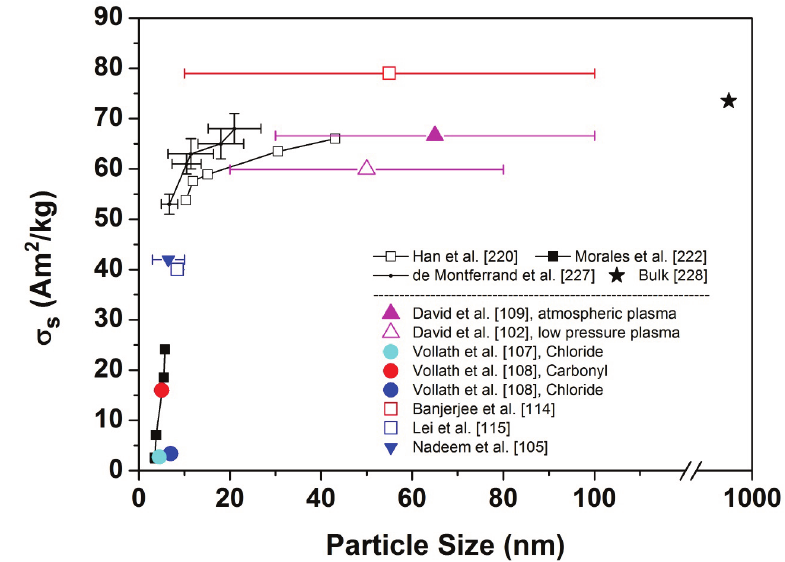
Figure 7. Room temperature saturation magnetization as a function of particle size. Reference data for particle size dependent saturation magnetization (all symbols in black color) are taken from Han et al. [220], Morales et al. [222], and de Montferrand et al. [227], and finally the bulk reference value is taken from [228], page 993. Literature data of the diverse plasma synthesized F O nanoparticles (colored symbols) are taken from Table 7 (David et al. 2 3 [102,109], Nadeem et al. [105], Vollath et al. [107,108], Banerjee et al. [114], Lei et al. [115]). The bars herein are not error bars; they show the spread of indicated particle